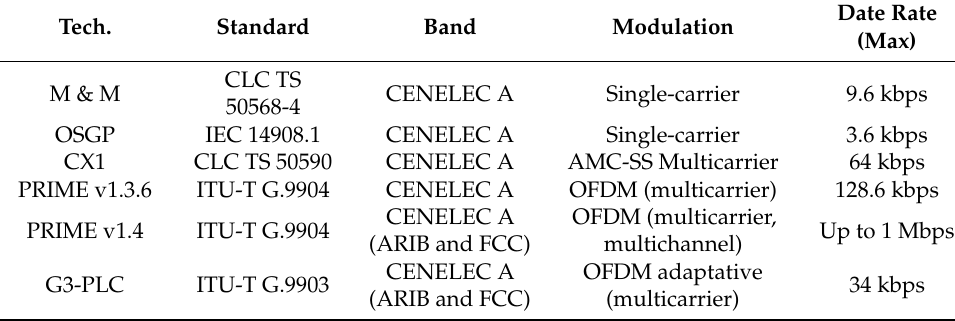
Table 1. Comparison between main NB-PLC technologies.